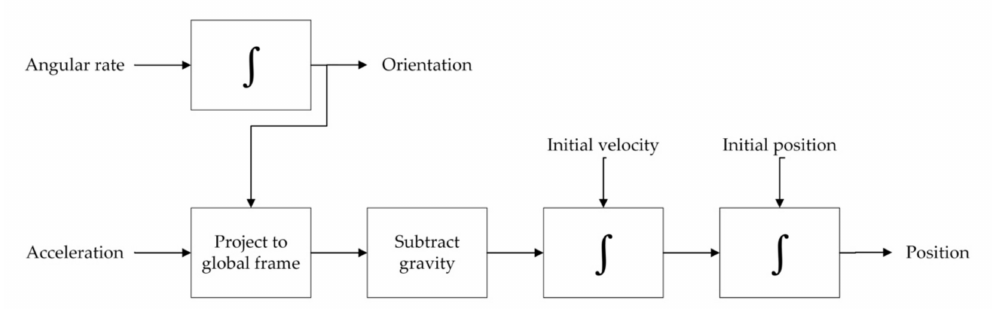
Figure 1. Schematic of the working principle of an IMU, redrawn from